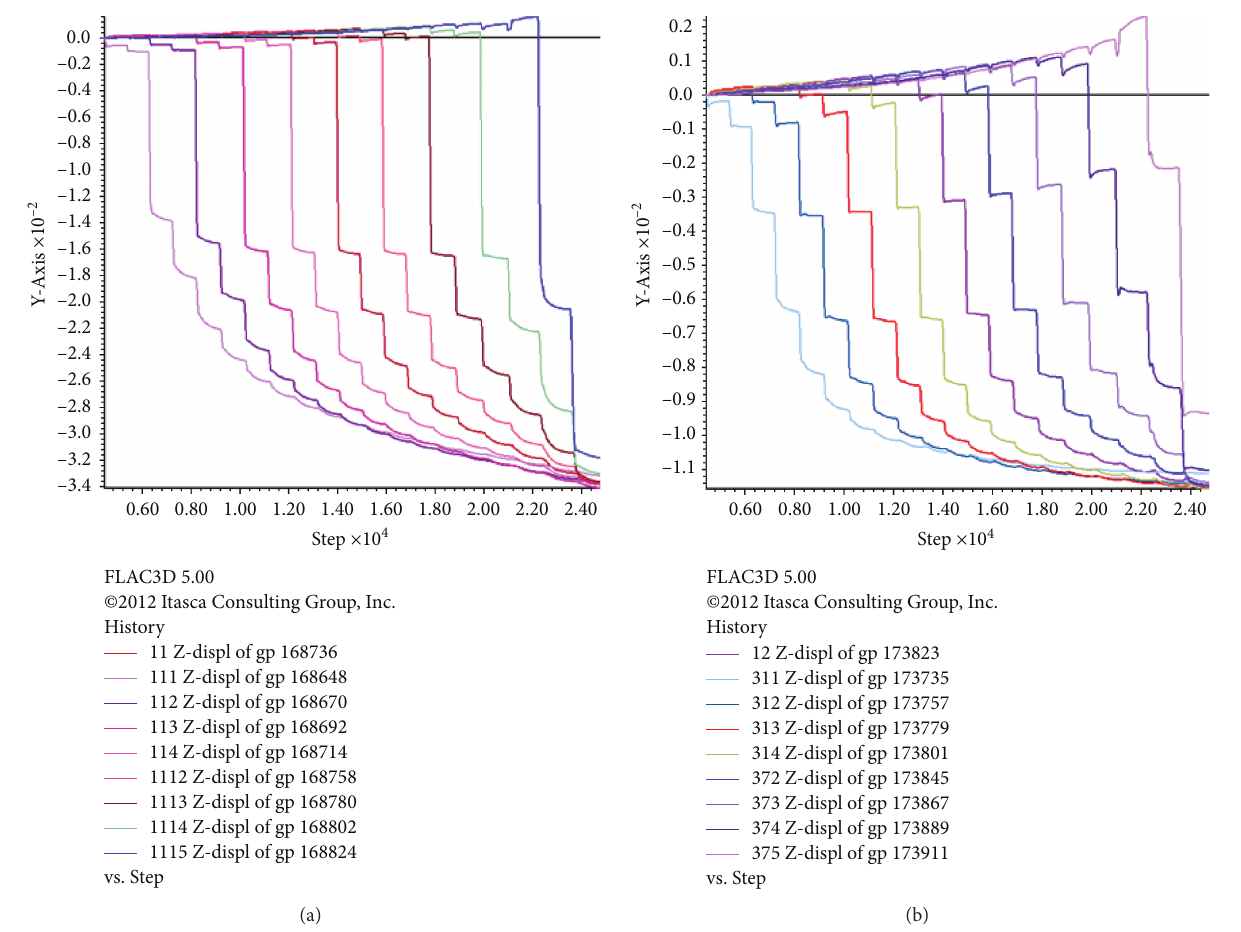
Figure 15: Vertical displacement curve of tunnel roof: (a) displacement curve of tunnel roof and (b) displacement curve of tunnel roof at 1m depth.